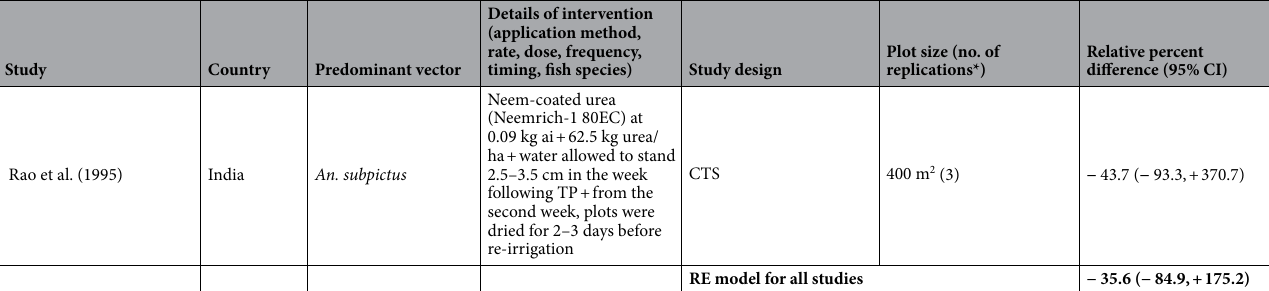
Table 2. Summary of findings of meta-analyses of the effect of riceland mosquito control on Anopheles larval density (the number of larvae and pupae per dip or area sampler), arranged by the type of control, study design and geographical region. Significant values are in bold. *The number of plots per treatment group. 1 CTS: Controlled time series. 2 CITS: Controlled interrupted time series. 3 DAT: Days after transplanting. 4 EC: Emulsifiable